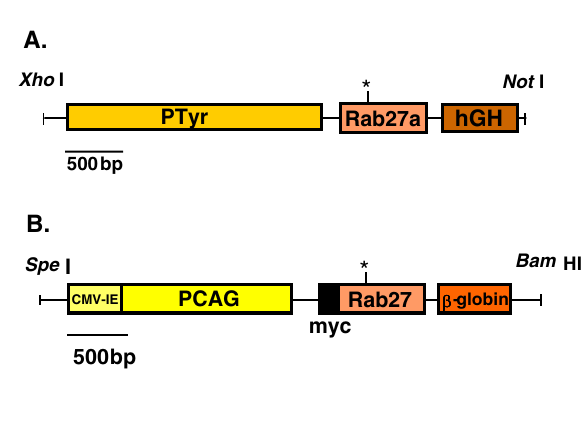
PTyr/Rab27a/hGH constructs and Panel B depicts the pCAG/ myc-Rab27/ β -globin constructs generated as described under "Methods". Point mutations are indicated by an